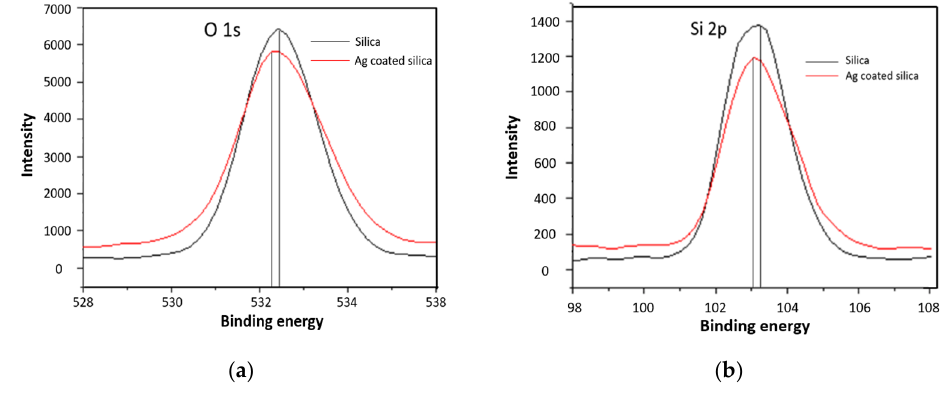
Figure 6. XPS peak transform of ( a ) O 1s and ( b ) Si 2p.